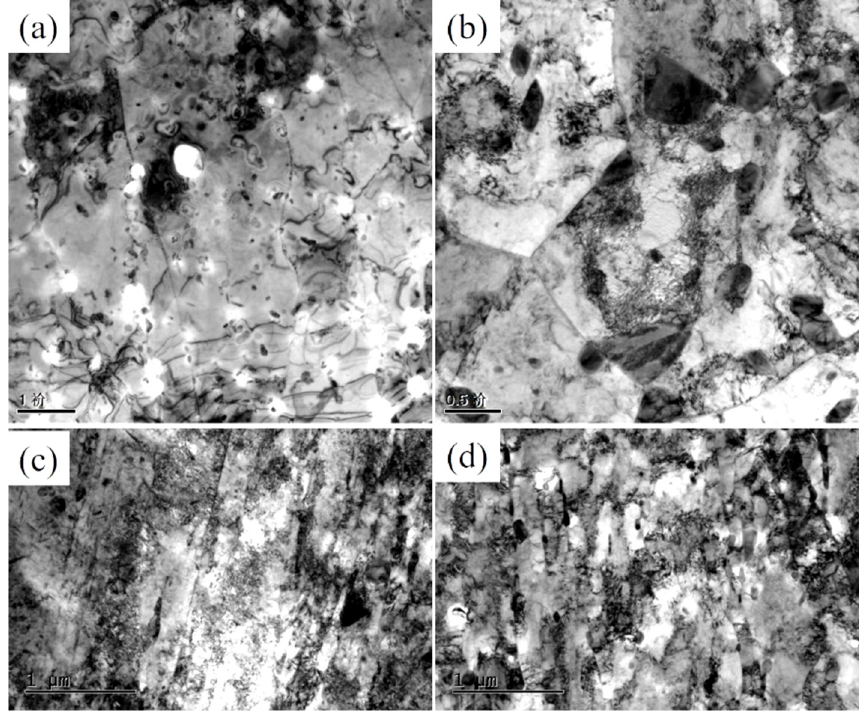
Figure 15. TEM microstructures of both steels at different strains. ( a ) 0.2%, Novel steel; ( b ) 0.2%, 30SiMn2MoV steel; ( c ) 0.6%, Novel steel; ( d ) 0.6%, 30SiMn2MoV steel.